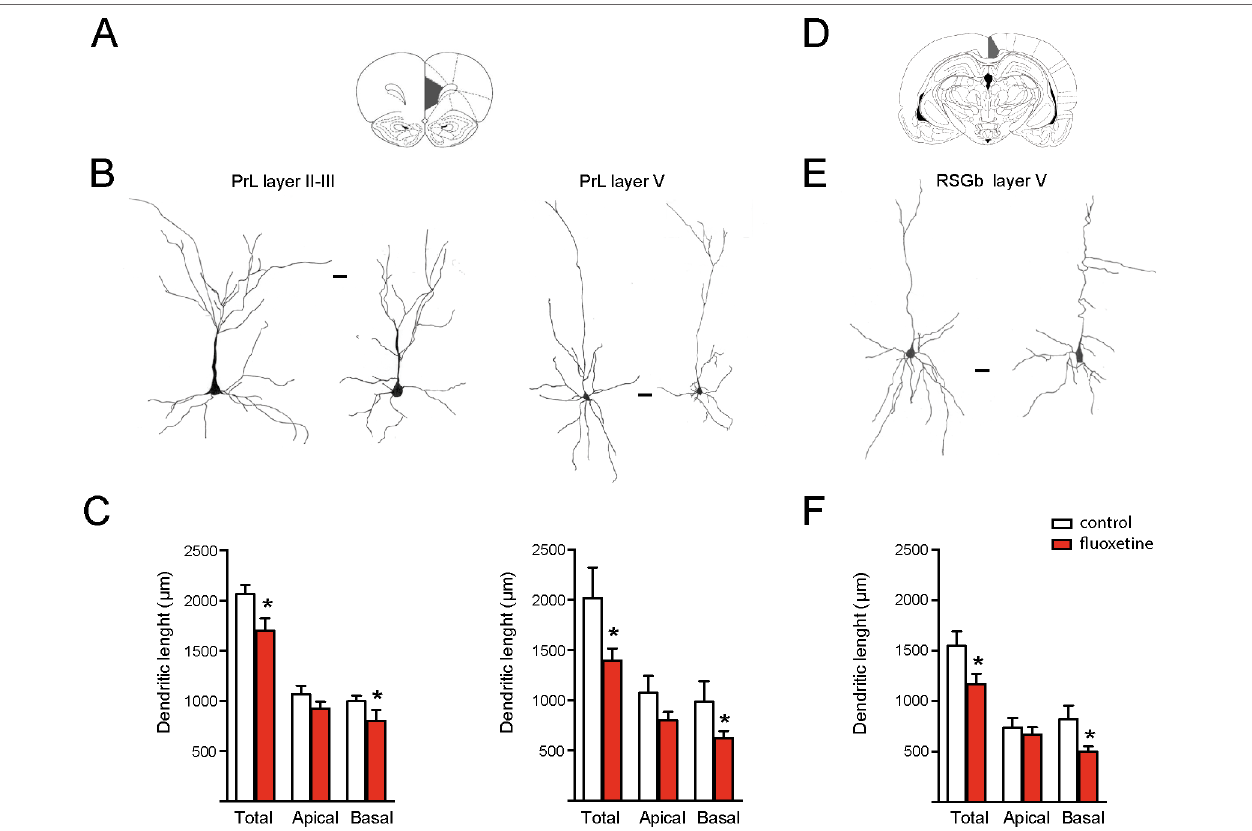
FIGURE 1 | Chronic fluoxetine treatment (28 days) decreased the dendritic length of pyramidal neurons in limbic cortices. Golgi staining was performed to analyze the prelimbic (PrL) and retrosplenial granular b (RSGb) cortices. Neurons were drawn with camera lucida and digitally scanned to visualize the morphology. (A) and (D) The analyzed areas are schematically shown (Paxinos and Watson, 1998). (B) and (E) Representative drawing of pyramidal neurons obtained from vehicle treated (control) or fluoxetine-treated rats. In the PrL cortex, layer II–III and V neurons were analyzed, while in the RSGb cortex, the analysis was restricted to layer V neurons. In each case, the neuron at the left is from the control (vehicle treated), while the neuron at the right is from the fluoxetine-treated animal. Scale bar: 20 µm. (C) and (F) Quantifications of the total, apical, and basal dendritic lengths of neurons in the PrL cortex (layers II/III in the left panel and layer V in the right panel) and RSGb cortices. Values represent the mean ± SEM. For each condition, we analyzed at least 10 neurons obtained from four animals per condition for the PrL cortex and three animals per condition for the RSGb cortex. * p ≤ 0.05, Mann–Whitney U